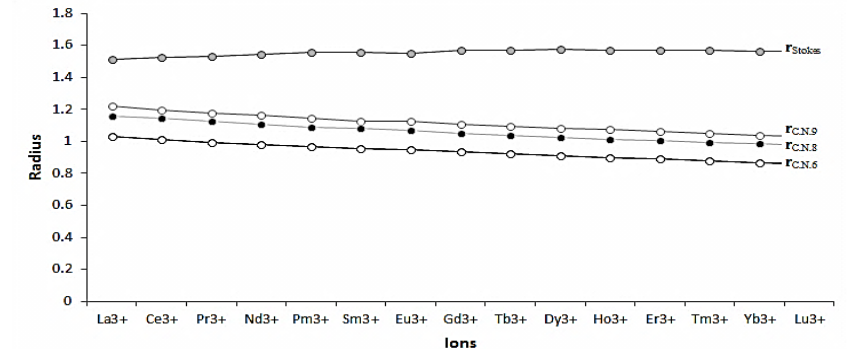
Fig. 6: The hydrodynamic and ionic radiuses (r ×10 -10 m) for lanthanide series in different coordination